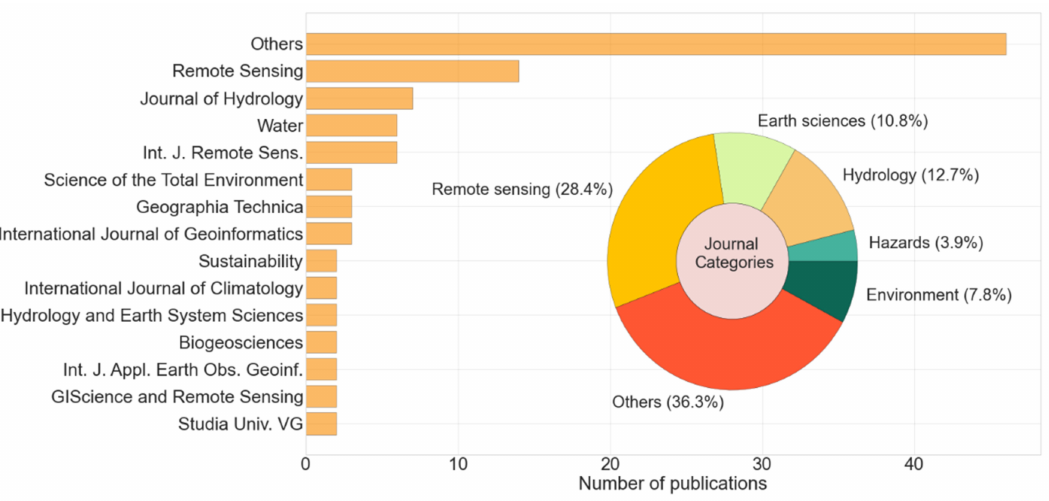
Figure 4. The number of journals and categories that reported drought publications in Southeast Asia between 2000 and 2021. The “others” in the horizontal bar plot represents journals with only one article, whereas the category “others” in the pie chart contains journals with broad topics that fall outside of the pre-defined categories (e.g., agriculture and forestry). Some of the journal abbreviations used in this figure follow the list compiled by the Swiss Federal Institute for Forest, Snow and Landscape Research (https://www.wsl.ch/, accessed on 25 March